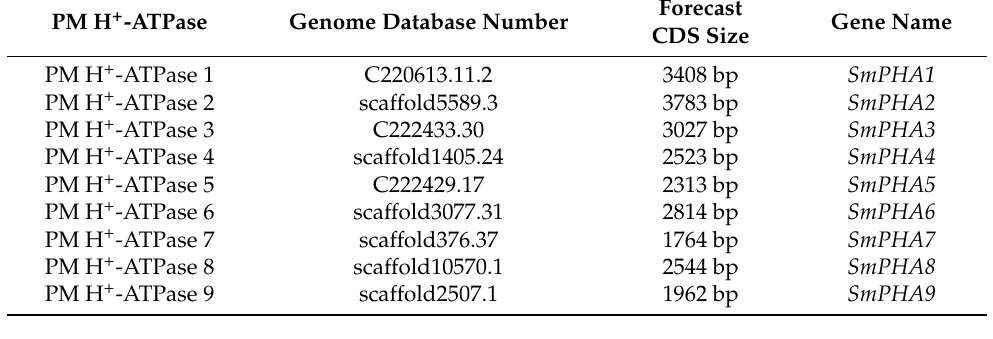
Table 1. Statistics of plasma membrane H + -ATPase in Salvia miltiorrhiza genome database.